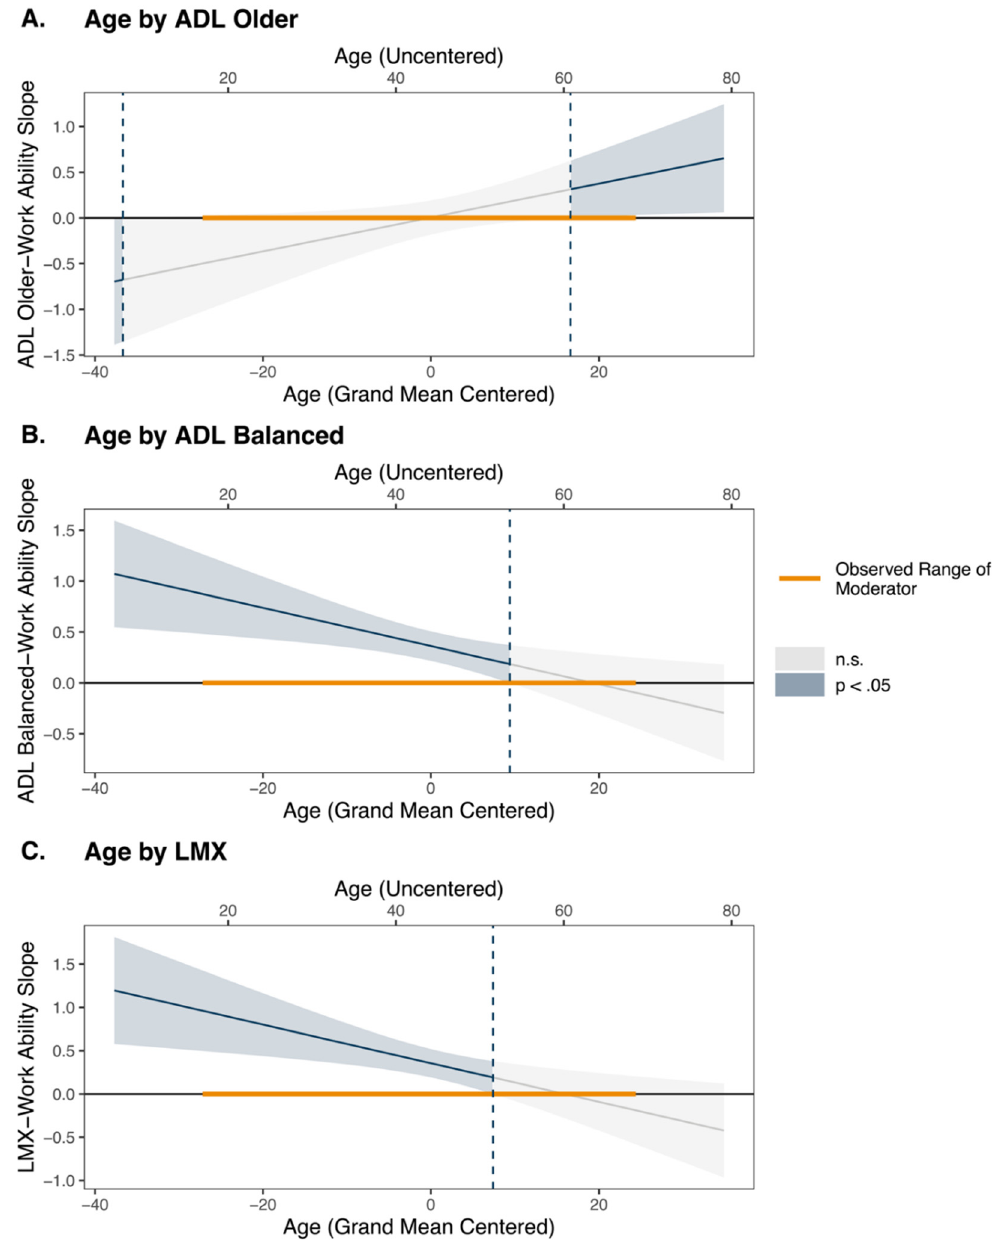
Figure 3. Johnson–Neyman Significance Regions Representing Age-Conditional Relationships of Leadership on Work Ability. Note. ADL = age-differentiated leadership; LMX = leader-member exchange. Chronological age and between-person leadership predictors (i.e., ADL Older, ADL balanced, and LMX) are grand mean centered.